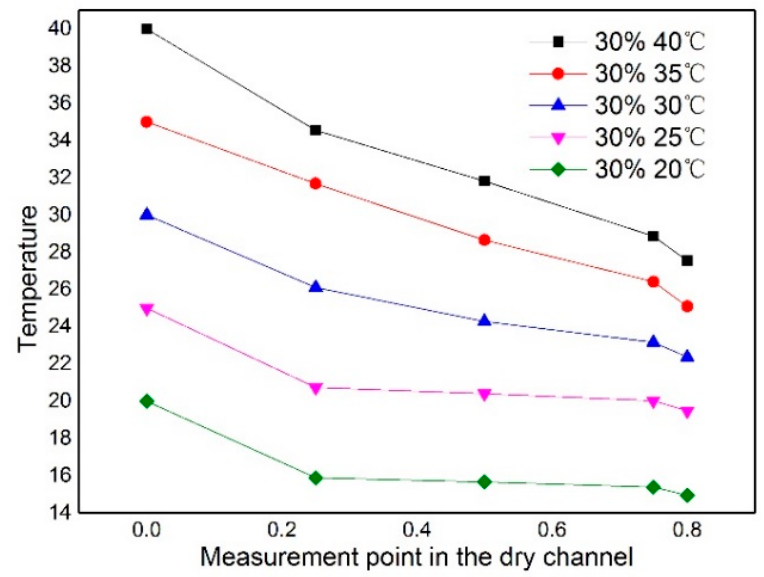
Figure 10. The temperature tendency in the dry channel for different inlet air temperatures.